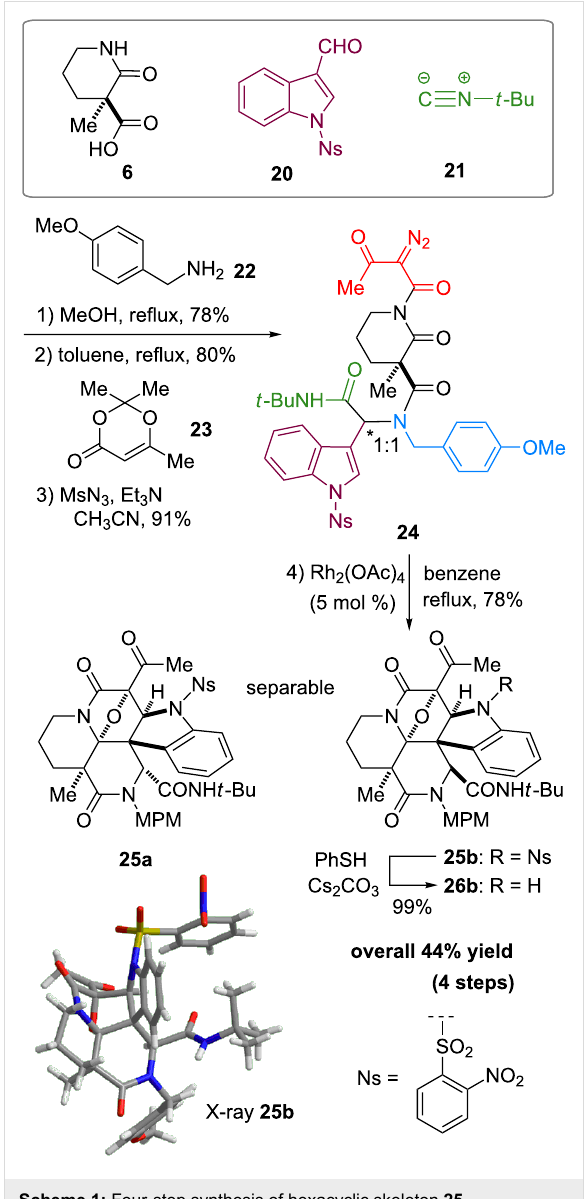
Scheme 1: Four-step synthesis of hexacyclic skeleton 25